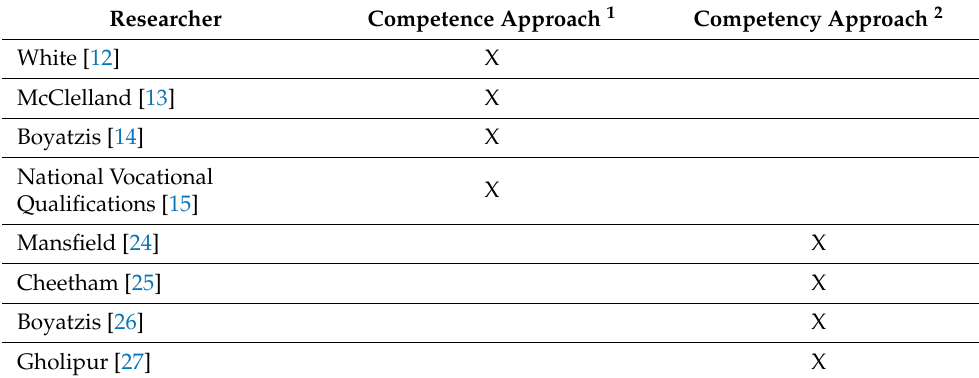
Table 1. Researchers’ contributions to the competence and competency